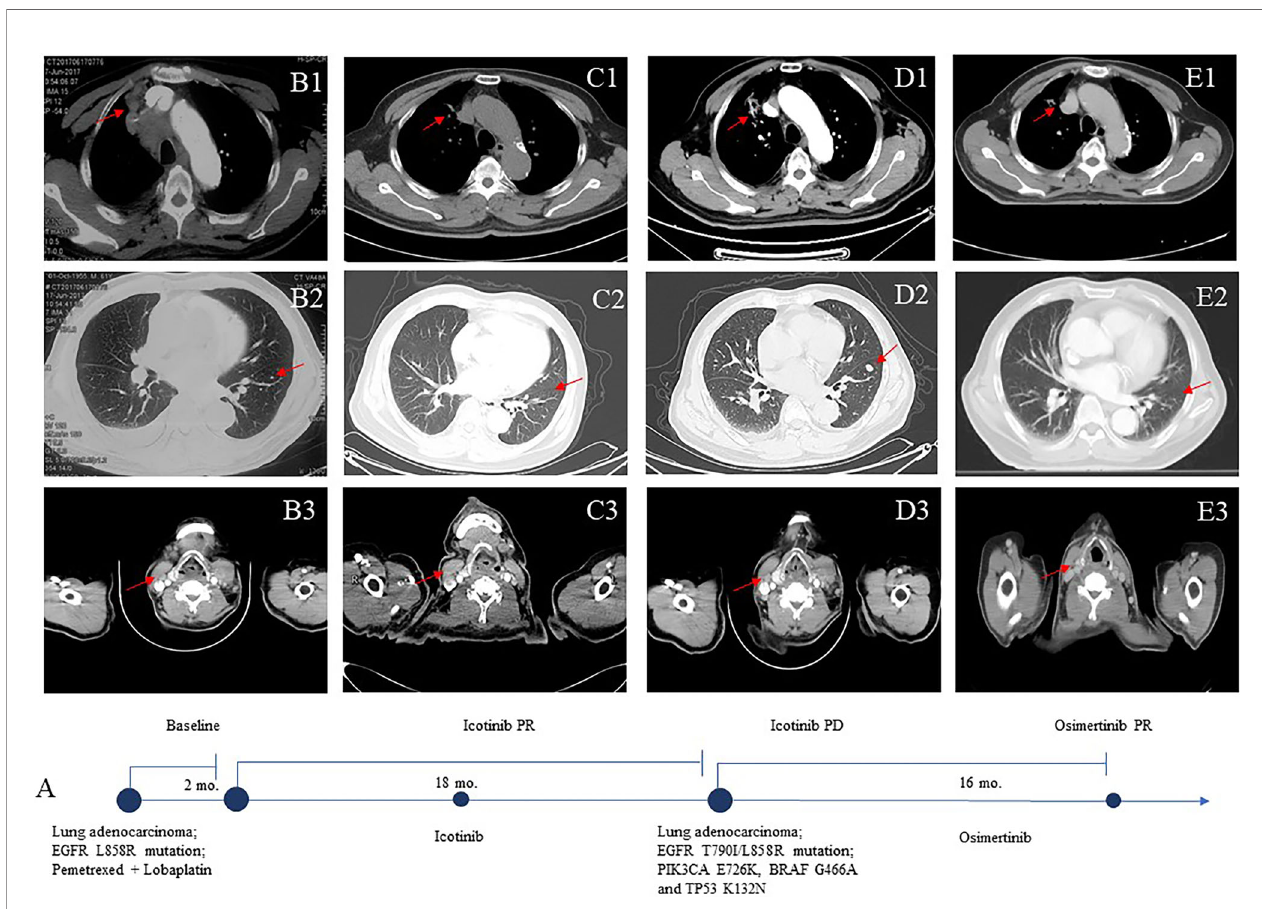
FIGURE 1 | Computed tomographic (CT) images (B – E) of the patient during treatment course (A) . Baseline images at diagnosis (June 2017) (B1 – 3) . Images after icotinib treatment (C1 – 3) . The patient ’ s upper lobe of the right lung, mediastinal and right hilar lymph nodes, bilateral pulmonary nodules, and right supraclavicular region were smaller. Eighteen months after icotinib treatment disease progression (D1 – 3) . The patient achieved a sustainable clinical bene fi t from osimertinib treatment (E1 – 3)